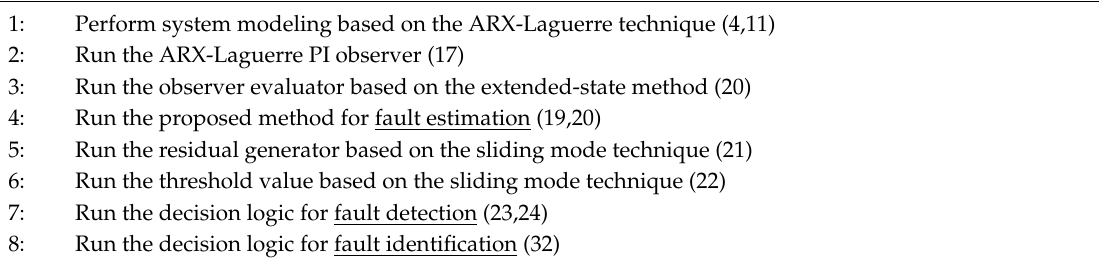
Algorithm 1. Extended-state ARX-Laguerre PI observer for fault diagnosis of an induction